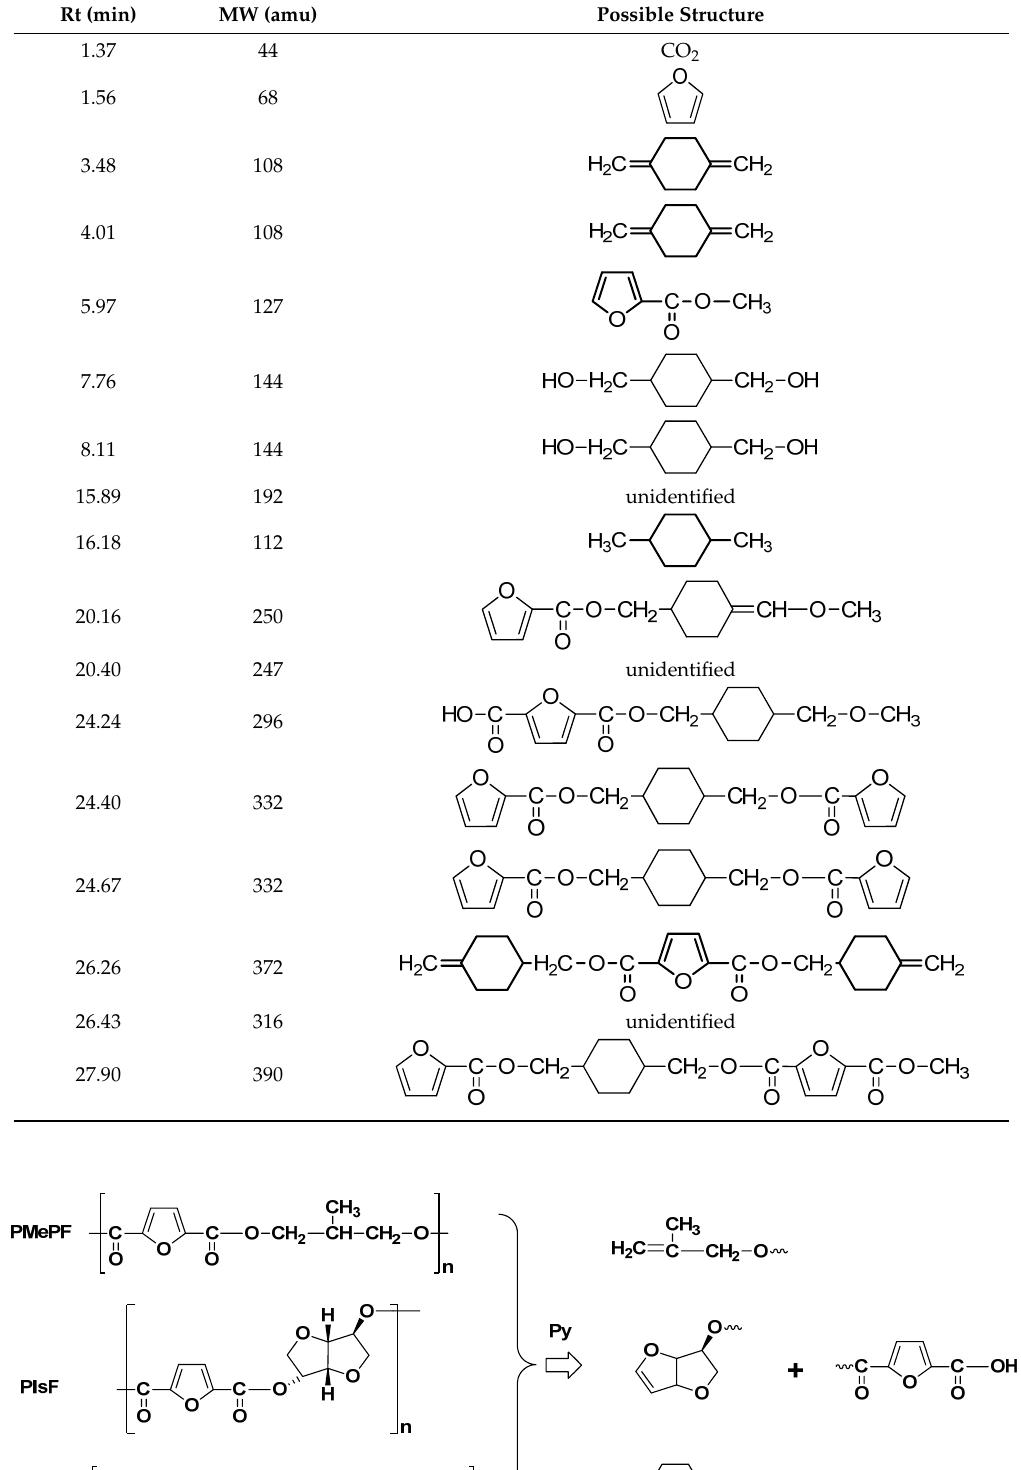
Table 5. Identified pyrolysis products of PCHDMF.